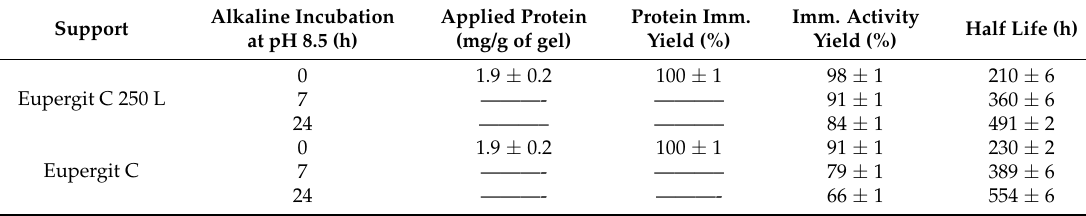
Table 2. Immobilization of D -xylose ( D -glucose) isomerase onto Eupergit C and Eupergit C 250 L and stabilization of the derivatives by glycine blocking or alkaline treatment.